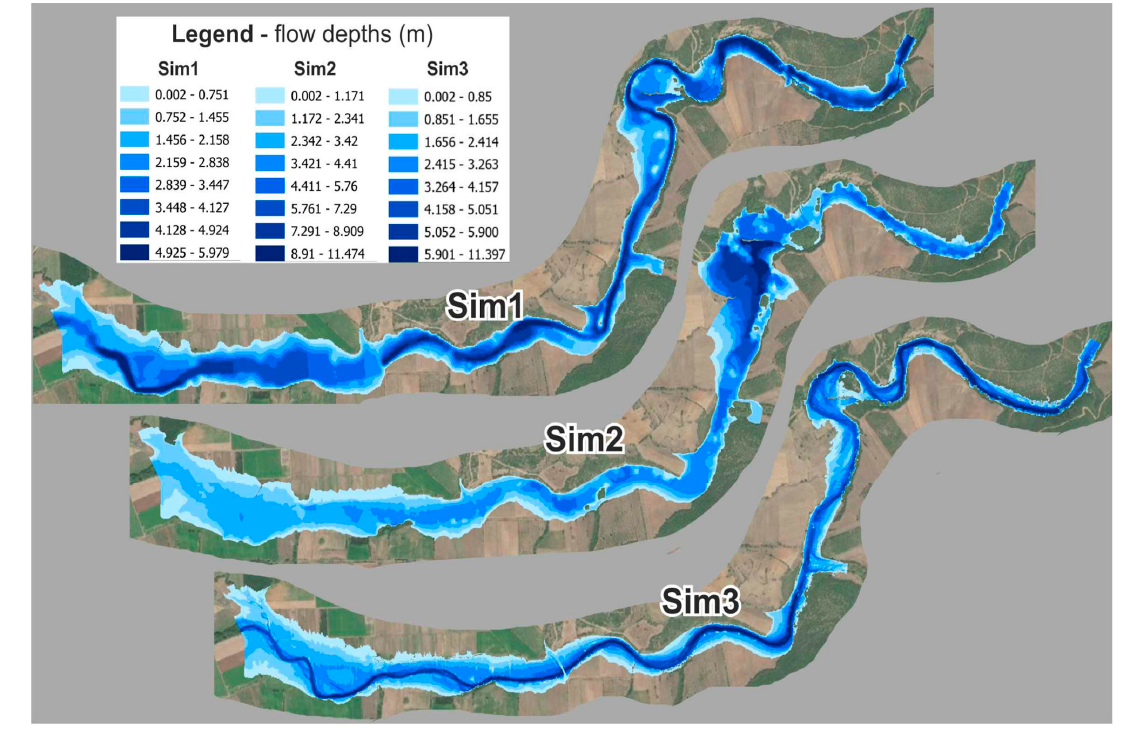
Figure 10. Flow depths of the three hydraulic simulations (Sim 1 = y_5 m; Sim 2 = y_2 m; Sim 3 = y_0.05 m; for separate hi-res maps see SM17, SM20, SM22).